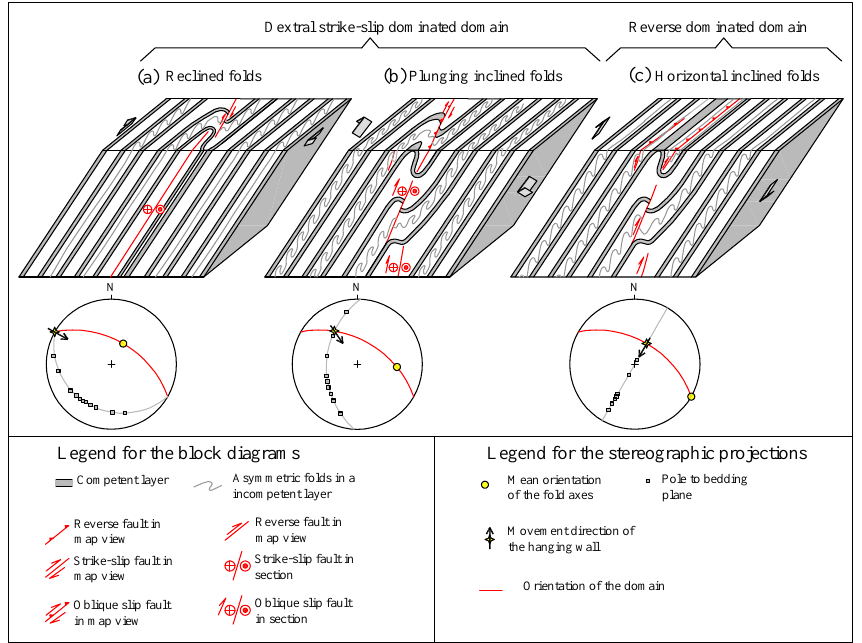
Figure 11. 3-D sketch diagrams adopted in this work on development of folds in two main types of deformational domains as dextral strike-slip and reverse dominated domains shown in Figs. 9b, 10 and